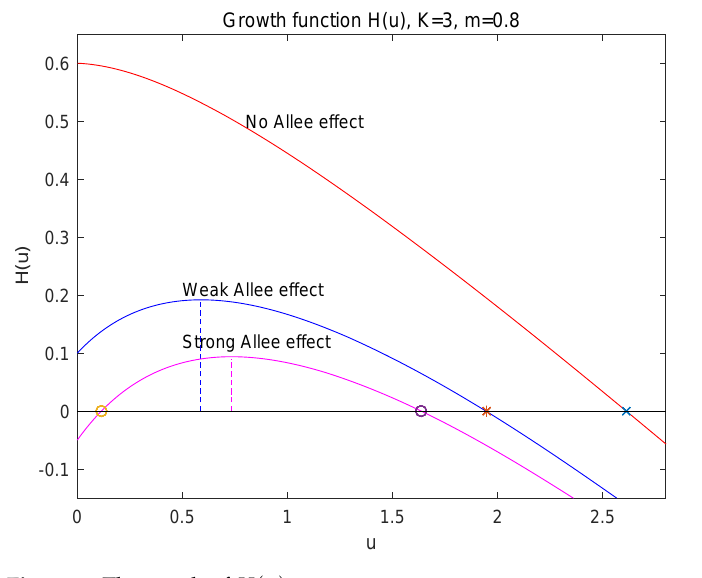
Figure 1. The graph of H ( u ) .